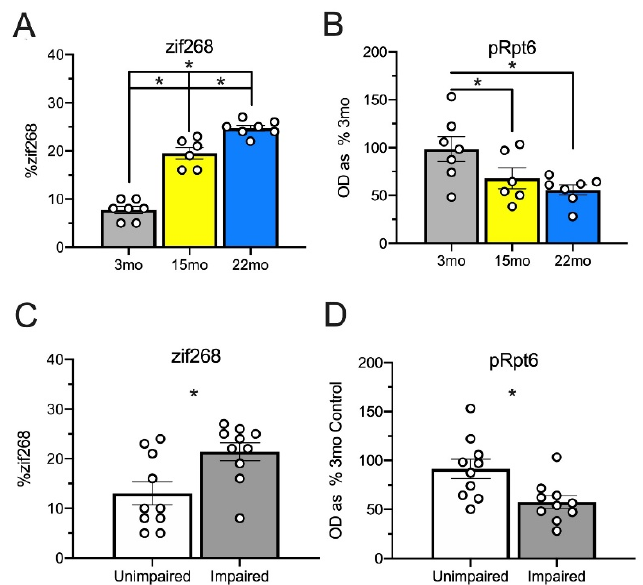
Figure 7. Levels of zif268 expression and pRpt6 in each ROI were averaged throughout the entire brain for each animal. Panels ( A , B ) represent zif268 ( A ) and pRpt6 ( B ) levels with groups constructed based on age group. zif268 levels di ff er between all age groups ( A ). Both 15-month-old and 22-month-old animals showed less pRpt6 than 3-month-old animals, but did not di ff er from each other. ( B ) Panels ( C , D ) represent zif268 ( C ) and pRpt6 ( D ) levels with groups constructed based on behavioral performance defined by a median split. Animals with impaired memory performance showed increased zif268 ( C ) and decreased pRpt6 ( D ) relative to unimpaired animals. Asterisks indicate p < 0.05. White dots represent individual rats.